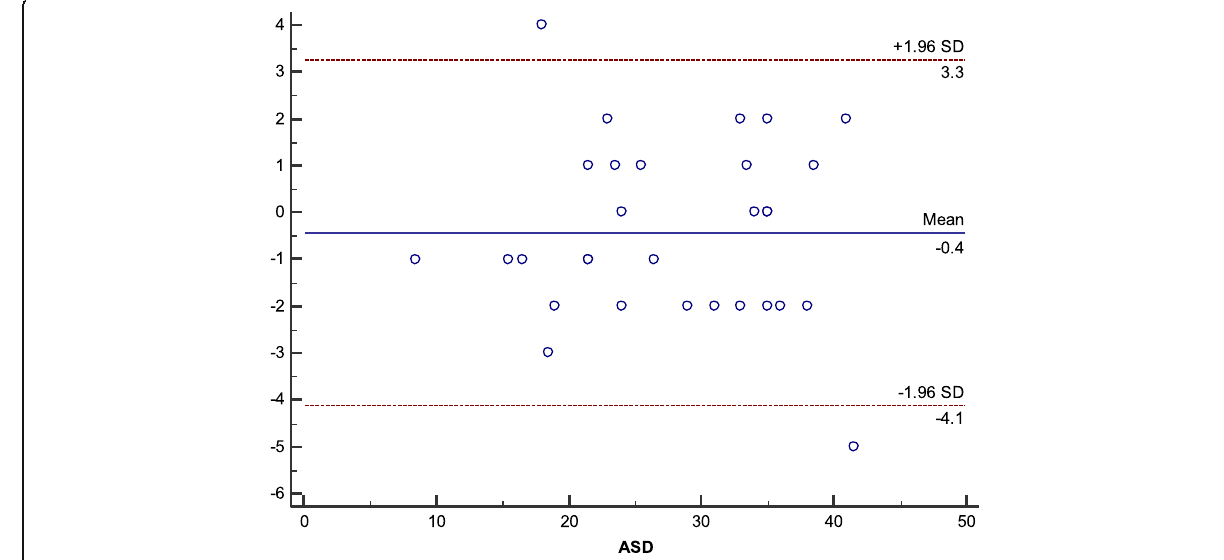
Fig. 4 Bland-Altman plot comparing ASD with TEE and MRI showed strong degree of agreement (0.96)